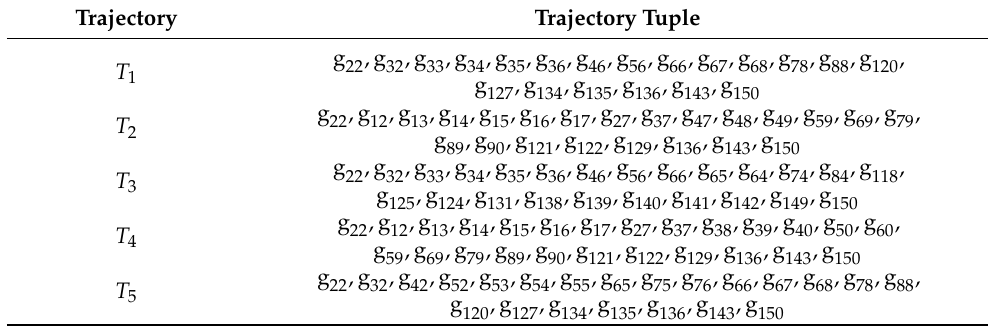
Table 2. The trajectory tuples of T 1 – T 5